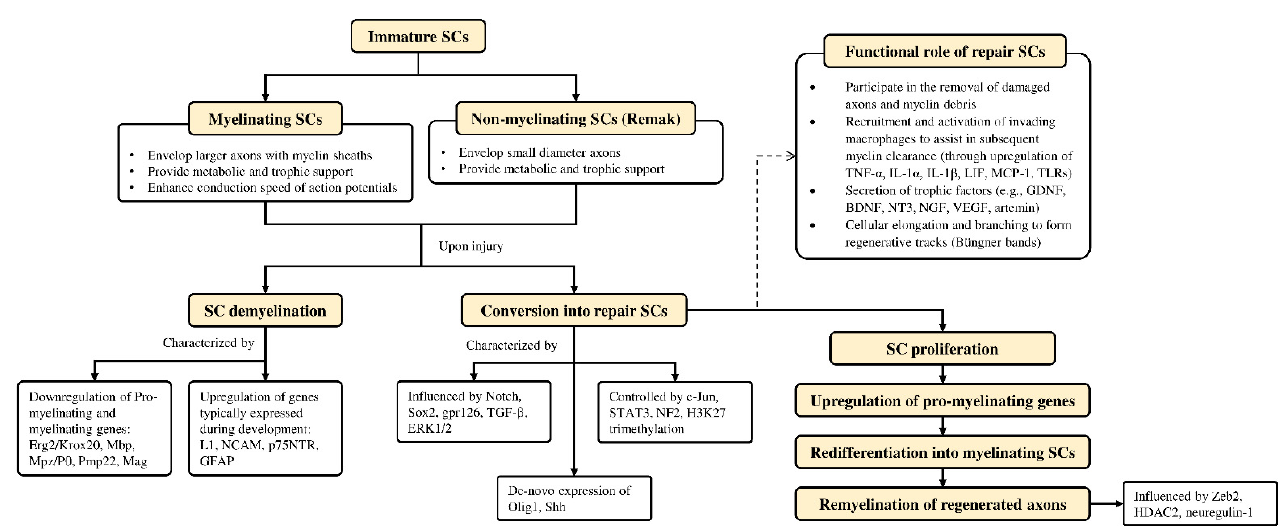
Figure 3. Overview of Schwann cell plasticity and their roles following peripheral nerve injury. Immature SCs develop into either myelinated or non-myelinated forms depending on the type of axon association. Upon nerve injury, SCs are capable of converting into a repair phenotype alongside the demyelination process that is mediated by different genes and transcriptional mechanisms. These events promote neuronal survival and enhance axonal regeneration following injury. Subsequently, repair SCs can be reprogrammed back to remyelinate regenerated axons. Further details on SC plasticity are presented in the reviews by Jessen & Mirsky [39] and Nocera & Jacob [100]. BDNF—brain-derived neurotrophic